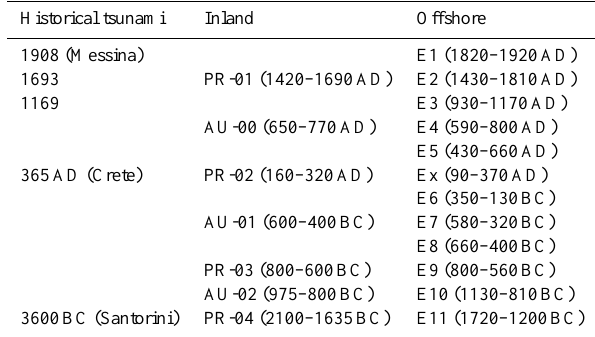
Table 1. Historical tsunami occurrences compared to age ranges of the geological tsunami evidence from the Augusta inland (De Martini et al., 2010) and offshore (Smedile et al., 2011). Historical tsunamis are retrieved from Tinti et al. (2007) except for the age of the Santorini event (Friedrich et al.,